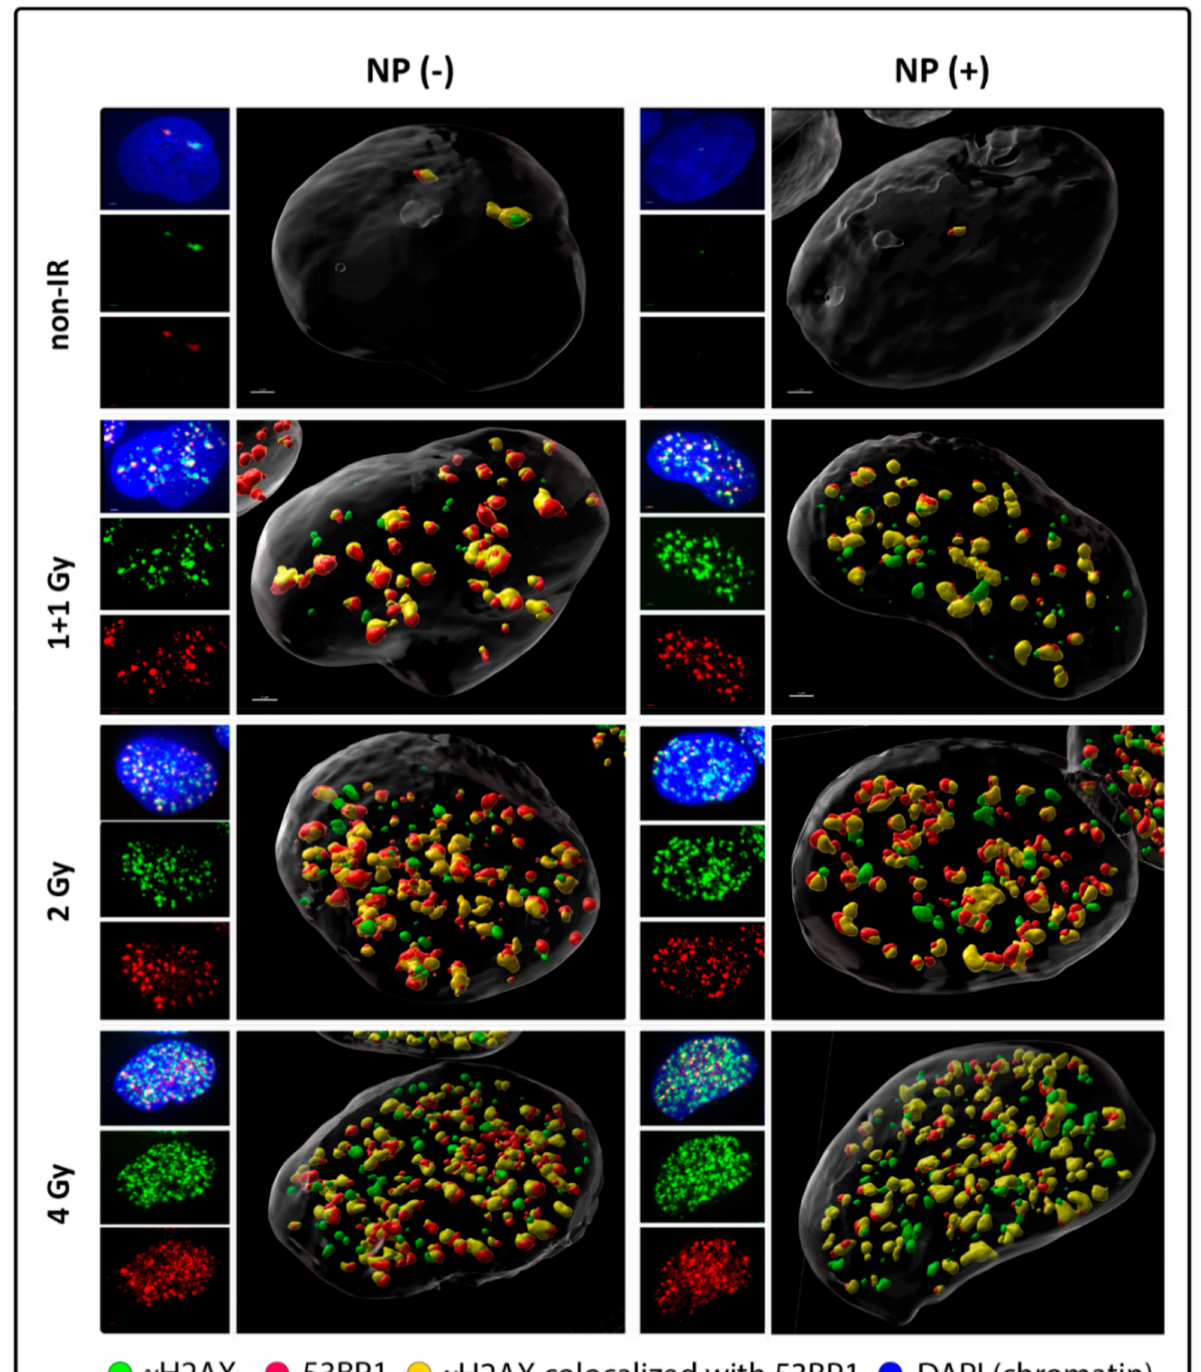
Figure 1. The quantity, morphology and extent of mutual colocalization of γ H2AX ( green ) and 53BP1 ( red ) repair foci generated within the nuclear DNA of SkBr3 mammary carcinoma cells with different doses of γ -rays in absence ( − ) or presence (+) of GNPs (0.4 µ g/mL for 18 h at 37 ◦ C prior to irradiation). The figure shows the situation at 0.5 h PI, i.e., the post-irradiation time of repair focus maximal occurrence. The micro-morphology and colocalization of foci in 3D space were reconstituted by Imaris software. For better visualization, γ H2AX foci colocalizing with 53BP1 are displayed in yellow while all 53BP1 foci (including those colocalizing with γ H2AX) in